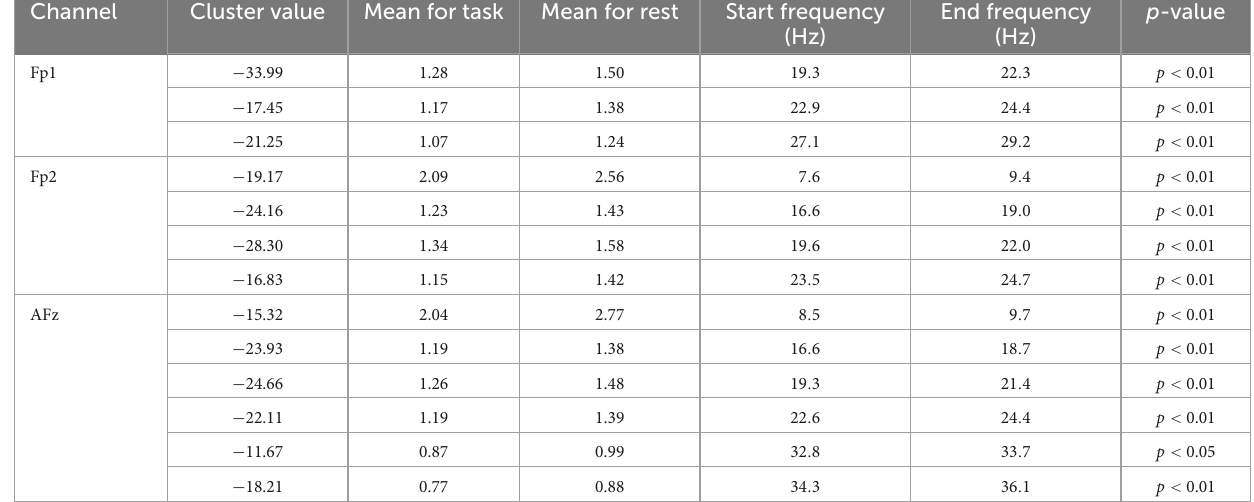
TABLE 2 Results of permutation test in No-Fm θ group.